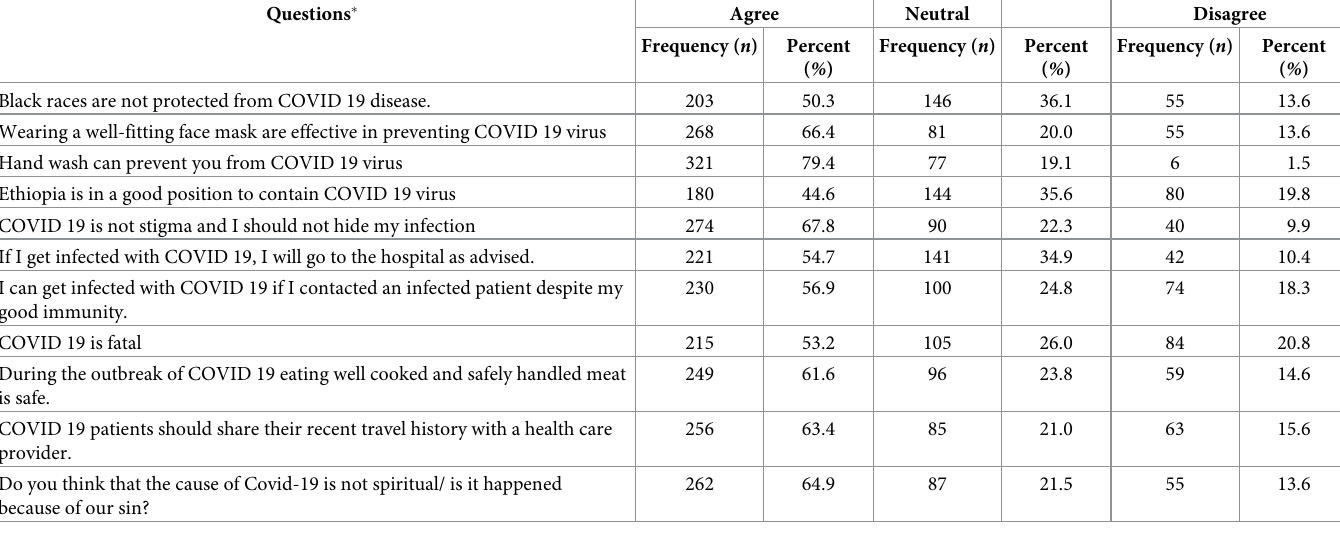
Table 3. Attitude of adult visitors towards COVID-19 prevention in hospitals of South Gondar zone, Northwest Ethiopia, August 1 to 30, 2020. Questions �